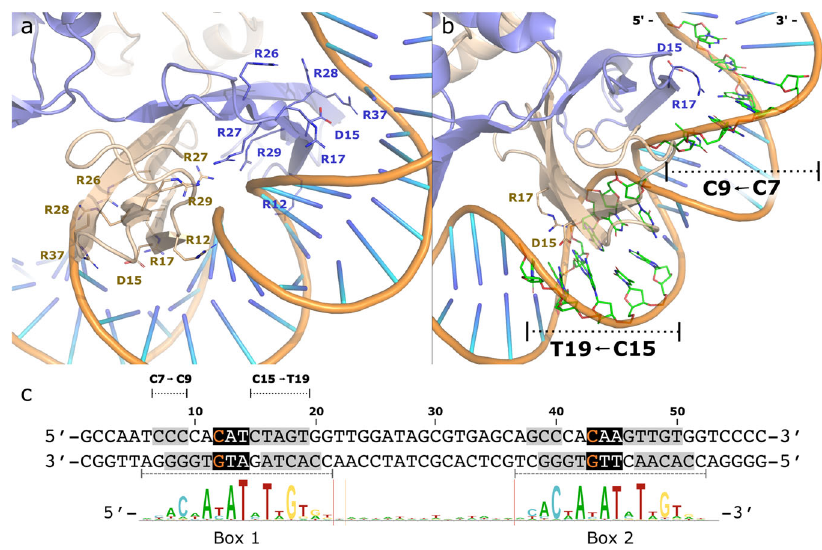
Fig. 3 Interactions between NrdR and DNA. a Chains A (beige) and D (blue) of the DNA-bound dATP/ATP-loaded NrdR bound to NrdR box 1. Arginine residues 12, 26 – 29, and 37 interact with the DNA phosphate backbone. b D15 and R17 are located close to the DNA bases in the major groove. c DNA sequence of the S. coelicolor nrdRJ promoter region (top) and sequence logo of identi fi ed NrdR boxes (bottom). Nucleotides interacting with NrdR (shaded gray); highly distorted interactions, with cross-base pair interactions (orange on black); middle of sharp bend (white on black).